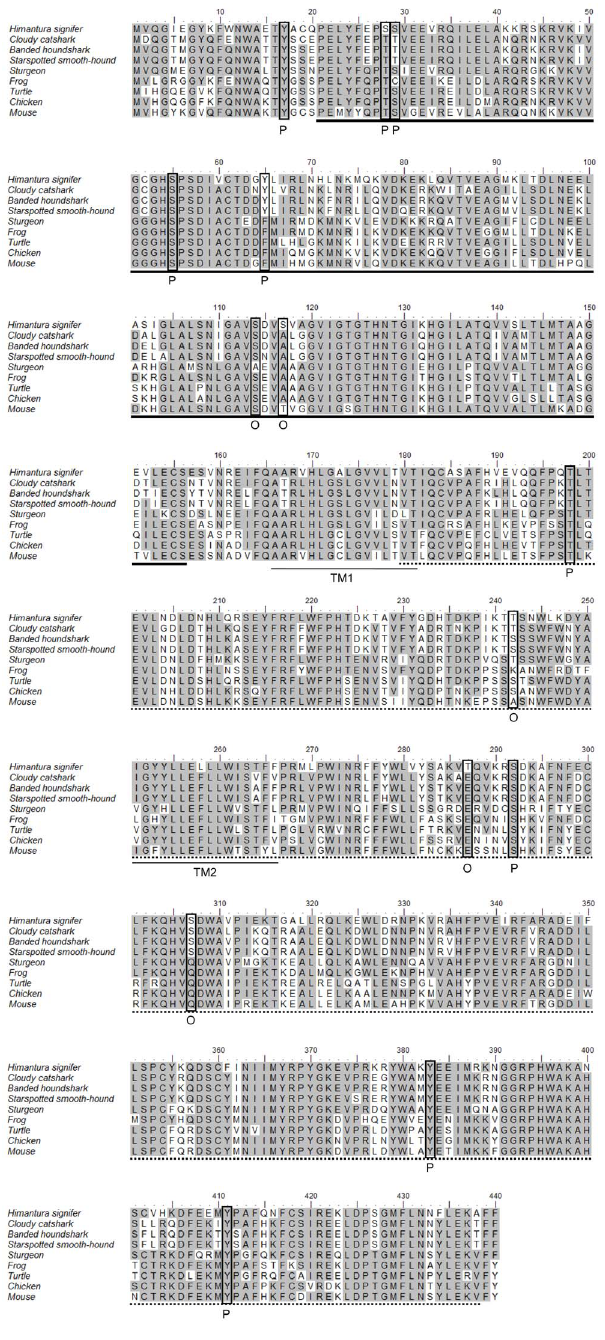
Figure 2. Multiple amino acid alignment of the deduced amino acid sequence of gulonolactone oxidase (Gulo) from the kidney of Himanturasignifer , with eight other known sequences of Gulo from GenBank; Scyliorhinustorazame (cloudy catshark Gulo; Q90YK3.1), Triakis scyllium (banded houndshark Gulo; ABO15547.1), Mustelus manazo (starspotted smooth-hound Gulo; ABO15548.1), Acipenser transmontanus (sturgeon Gulo; ABO15549.1), Xenopus laevis (frog GULO; NM_001095065), Pelodiscus sinensis (turtle GULO; AET14634.1), Gallus gallus (chicken GULO; XM_001234313), and Mus musculus (mouse GULO; P58710.3). Identical amino acids are indicated by shaded residues. The FAD-binding and ALO domains are underlined in bold and dotted lines respectively. P denotes potential phosphorylation sites. O denotes potential O-GlcNAcylation sites. The predicted